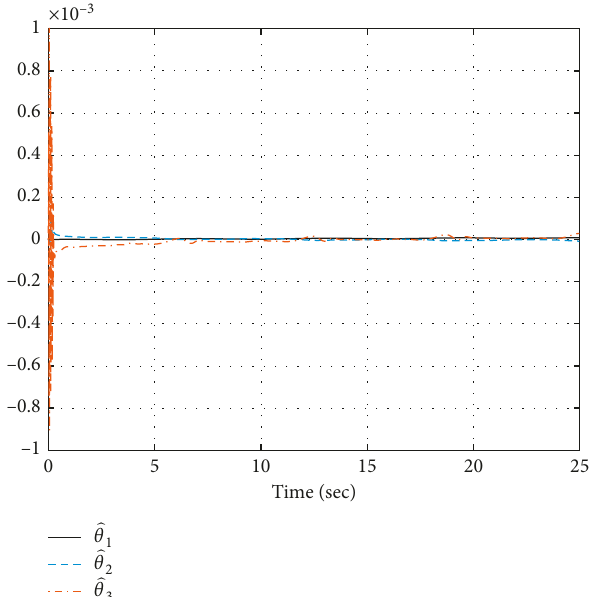
Figure 10: Evolution of the estimation of the unknown